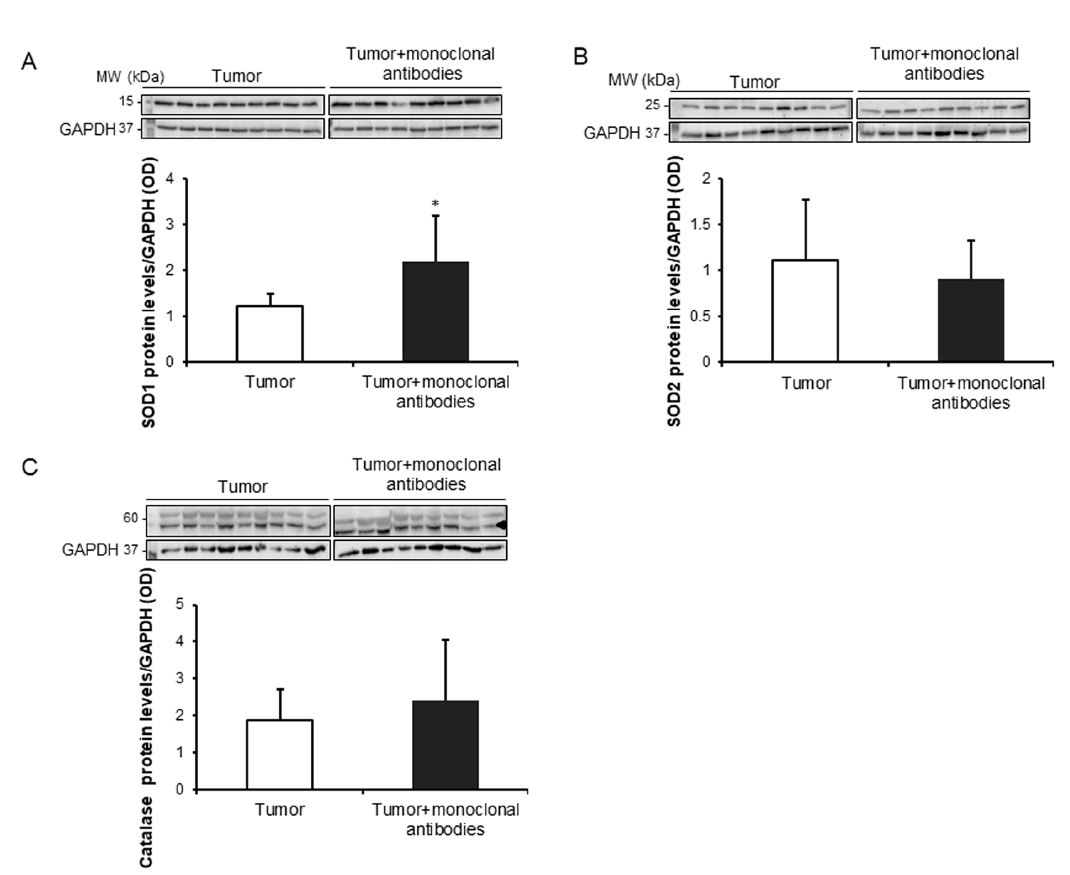
Cancers 2019 , 11 , x 9 of 16 Figure 4. ( A ) Representative immunoblots and mean values and standard deviation of total protein tyrosine nitration levels/GAPDH in subcutaneous tumors of lung cancer mice as measured by optical densities. ( B ) Representative immunoblots and mean values and standard deviation of total MDA